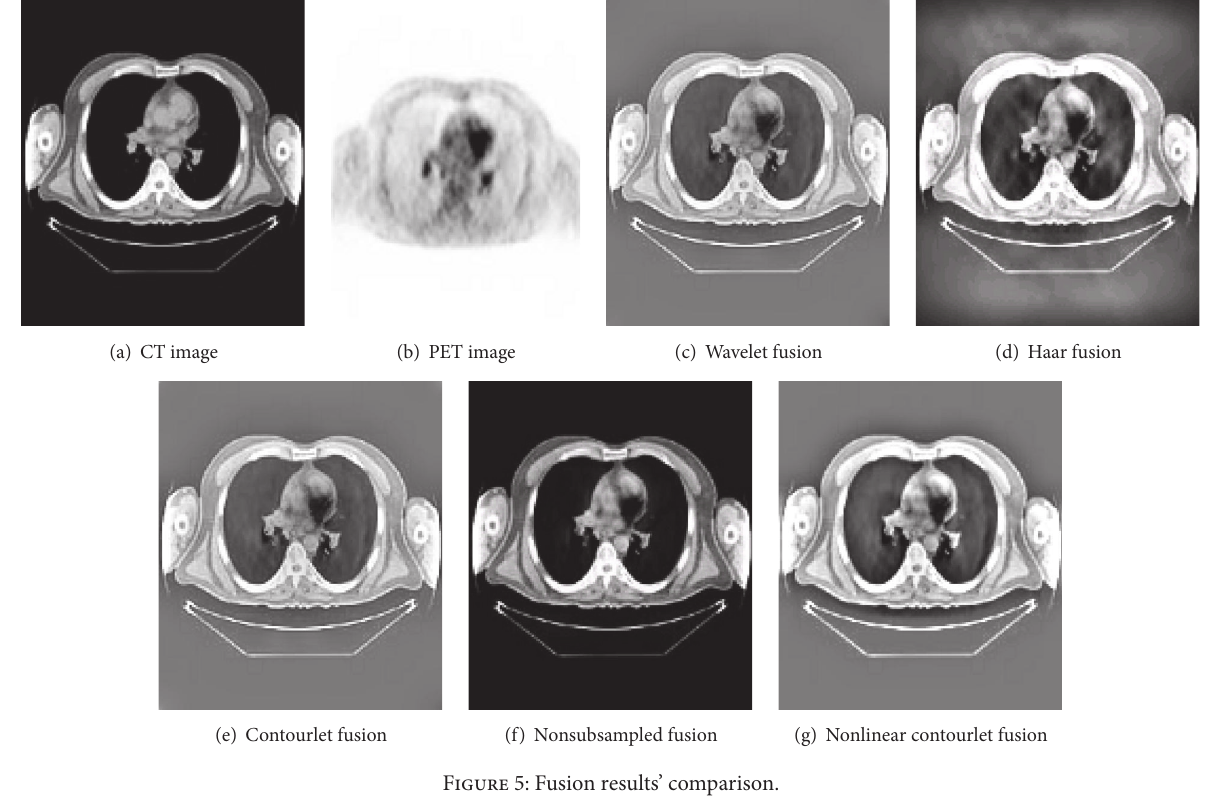
Figure 5: Fusion results’ comparison.